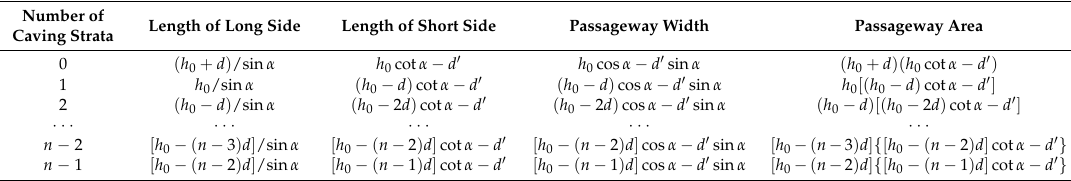
Table 1. The parameters of the parallelogram fracture passages generated at both ends of the trapezoid in model